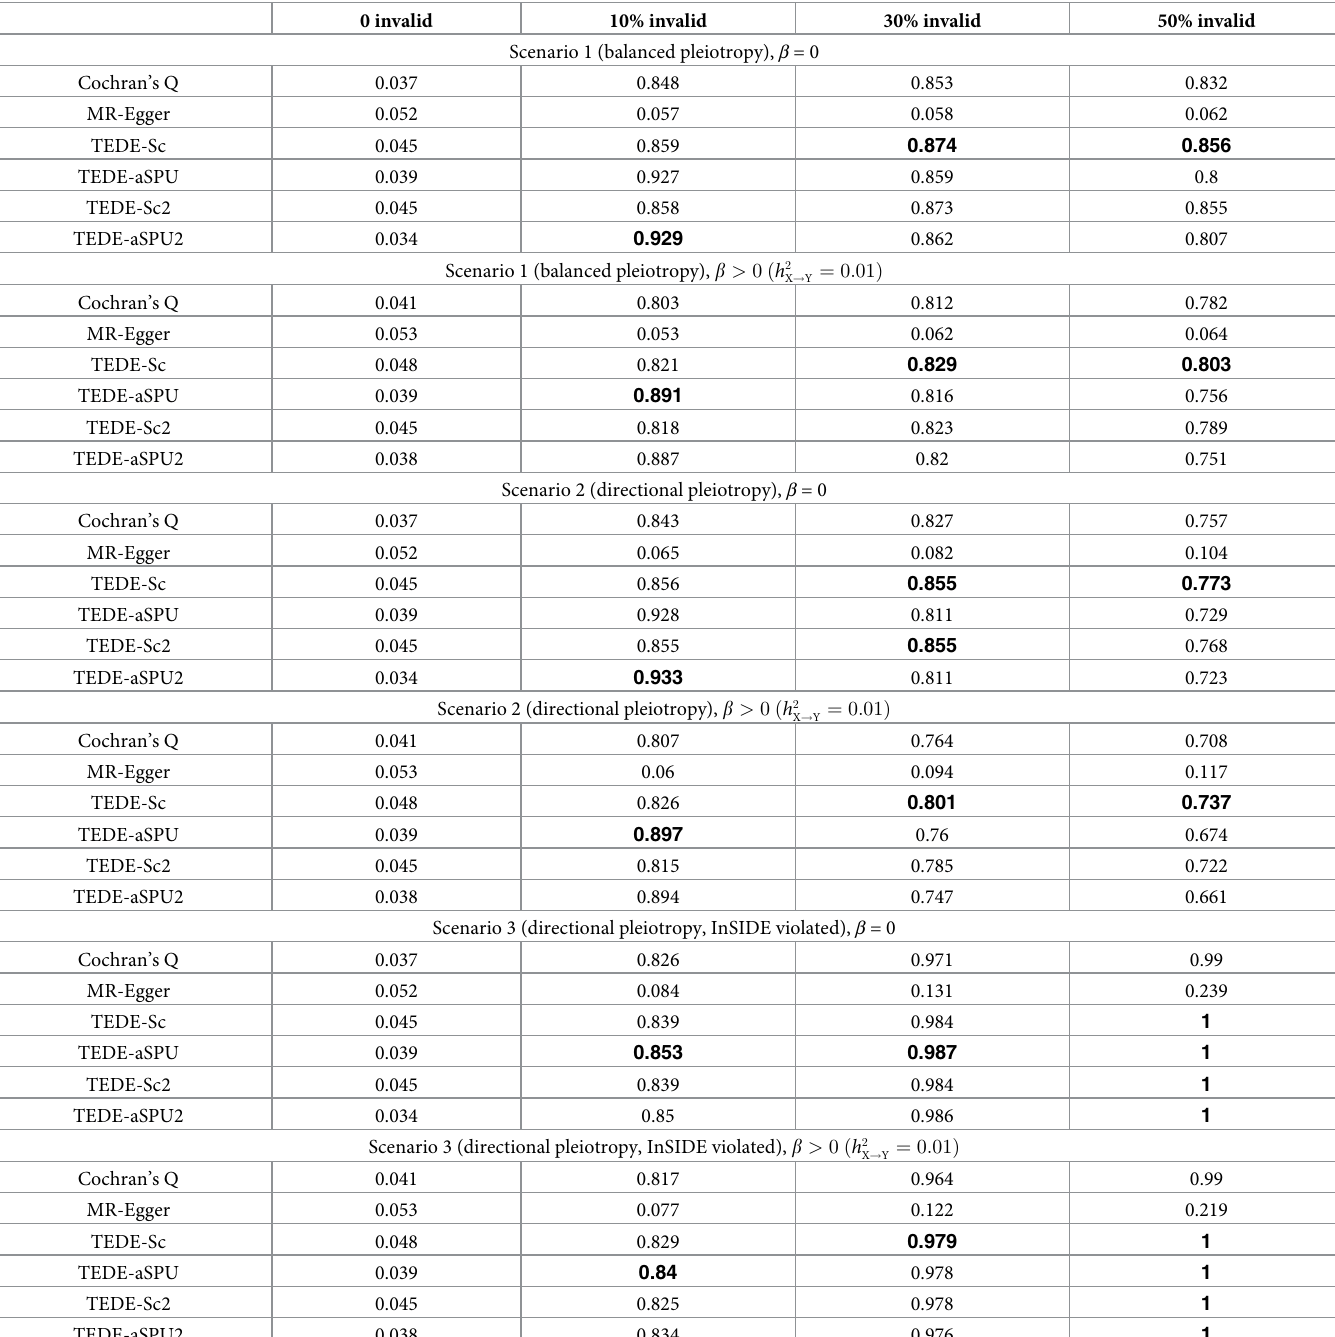
Table 1. Rejection rates (type I error when there is 0 invalid IV; power otherwise) for testing horizontal pleiotropy. Independent variants. 1000 iterations. p = 30, n 1 = 10000, n 2 =